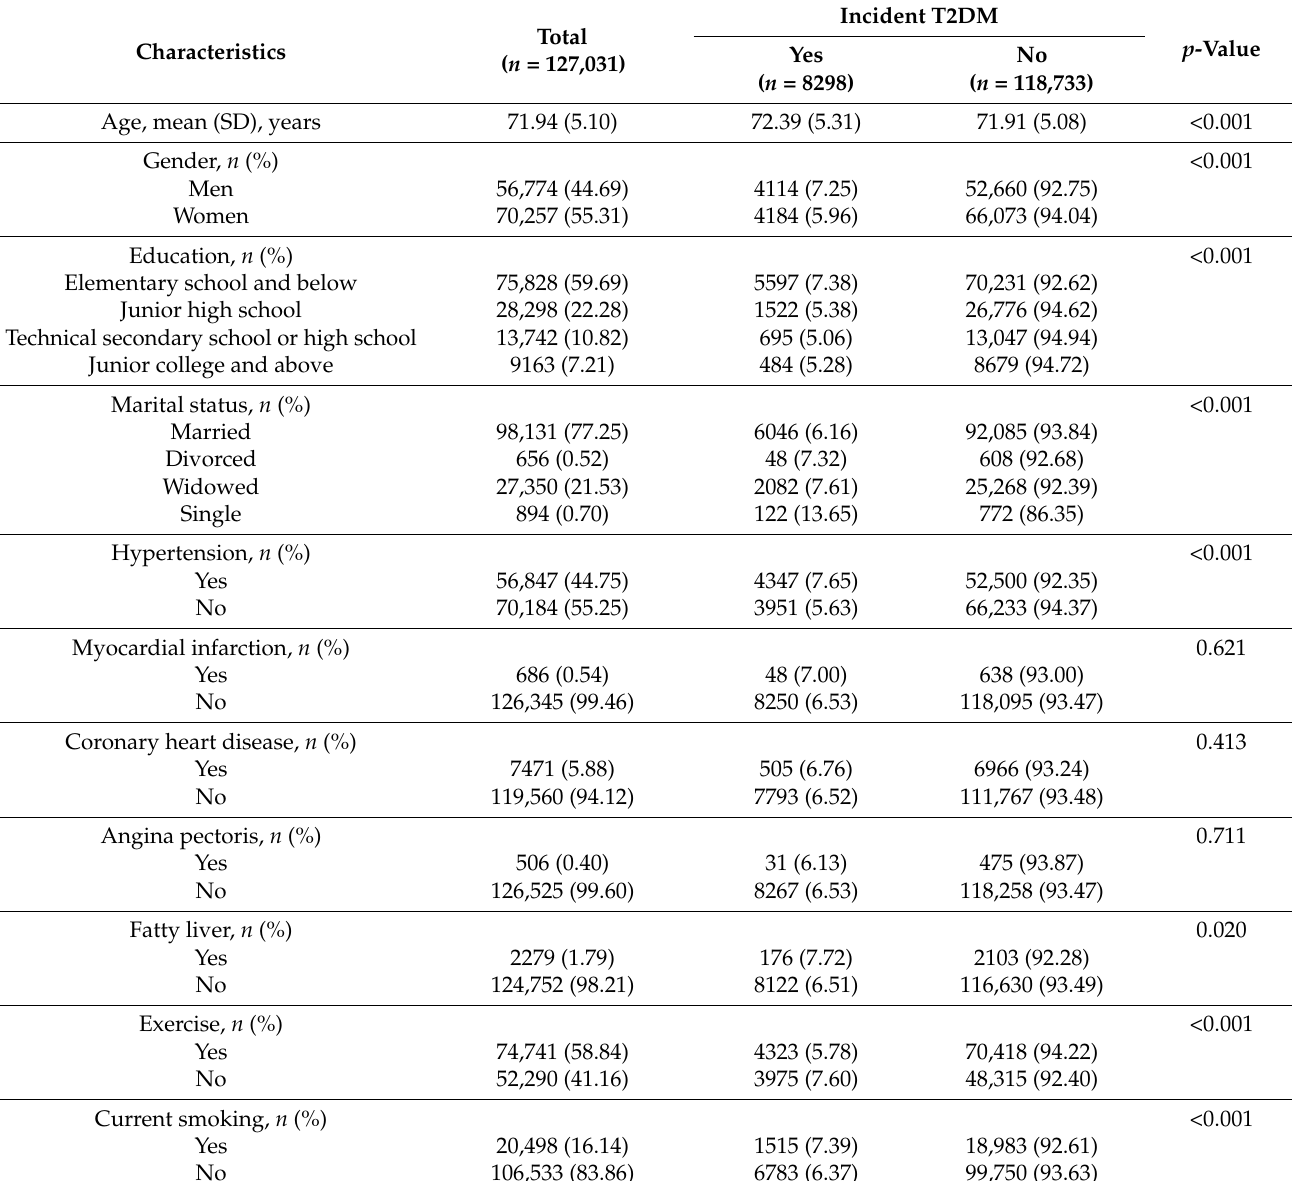
Table 1. Baseline characteristics of the